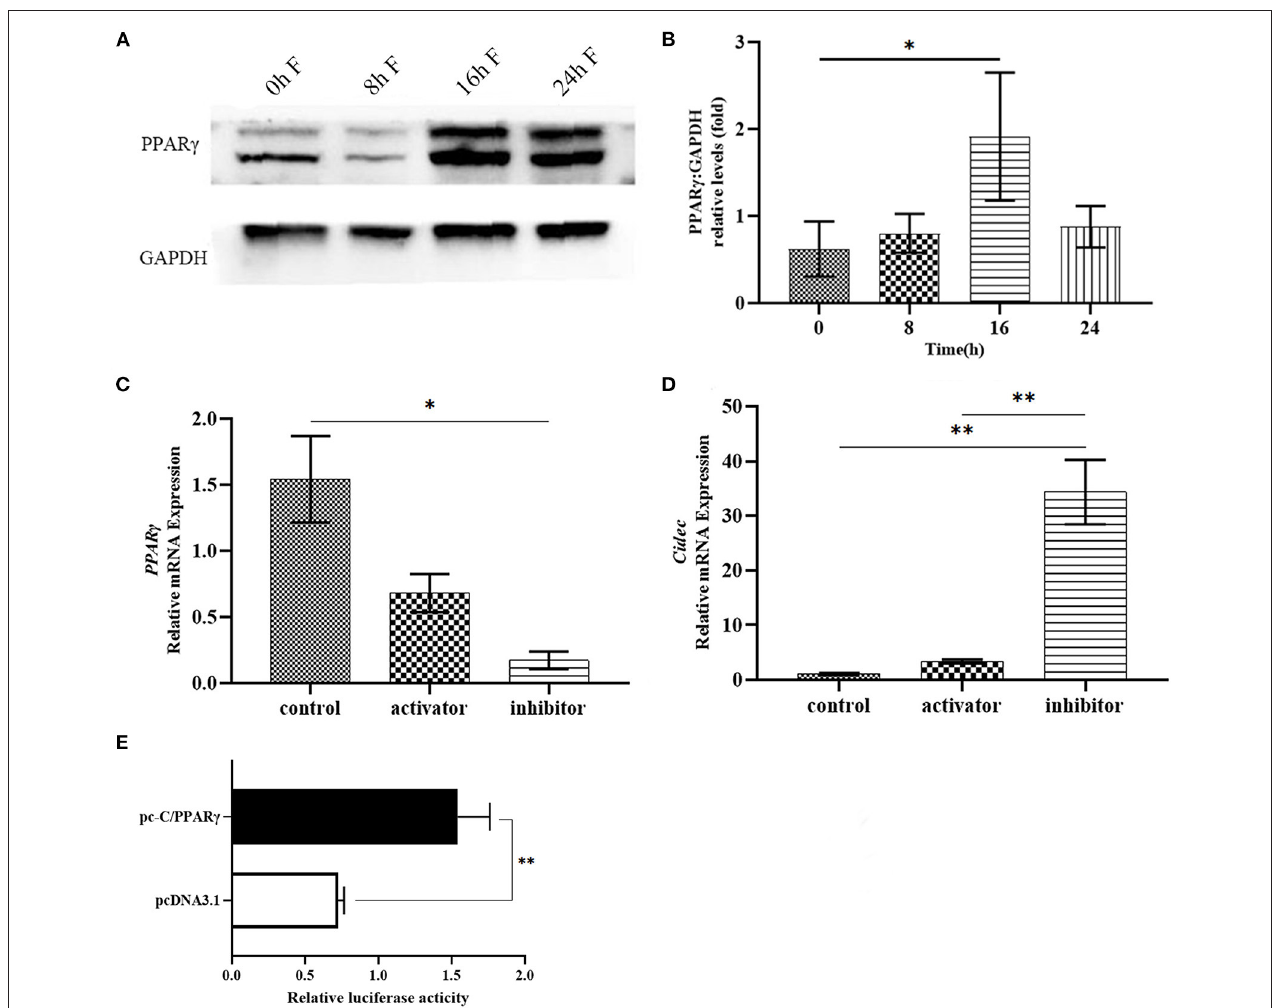
FIGURE 6 | Effects of fasting on the expression of PPAR γ in the liver of HFD mice. (A) Protein levels of PPAR γ in the liver of HFD mice after fasting at different times. (B) Histogram plotted by the grayscale values of PPAR γ relative to Gapdh. (C,D) Activation and inhibition of AMPK on the mRNA expression of PPAR γ and Cidec. β -actin was used as the internal control. (E) Binding of PPAR γ to the promoter region of Cidec was assessed by luciferase activity. Data were analyzed by t-test. * P < 0.05, ** P <